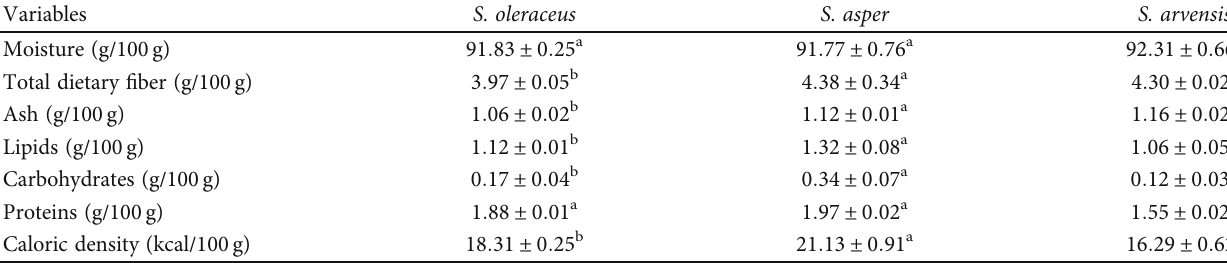
Table 1: Mean values of macronutrients and caloric density in Sonchus species.